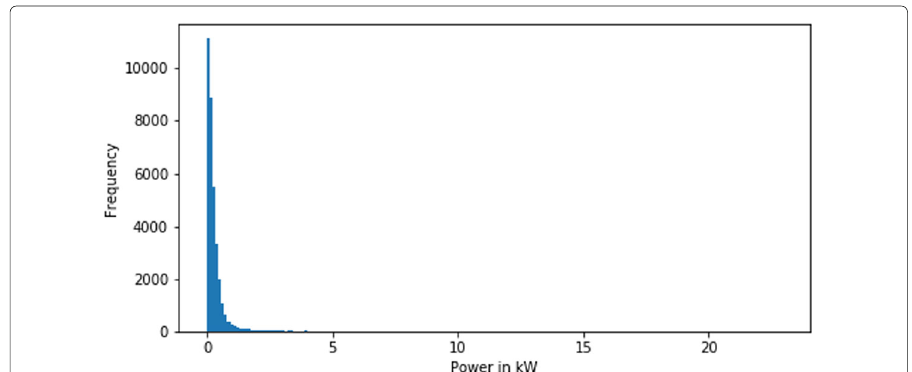
Fig. 9 Histogram with 200 bins showing the distribution of one household’s load over one year. Like the other households in the dataset, this household has a low mean value (0.38 kW) and a high maximum value (22.92 kW). Every value above 2 or 3 kW can be considered as peak load event. Using a normal or even uniform distribution increases the likelihood of peak loads in any household. This also increases the probability